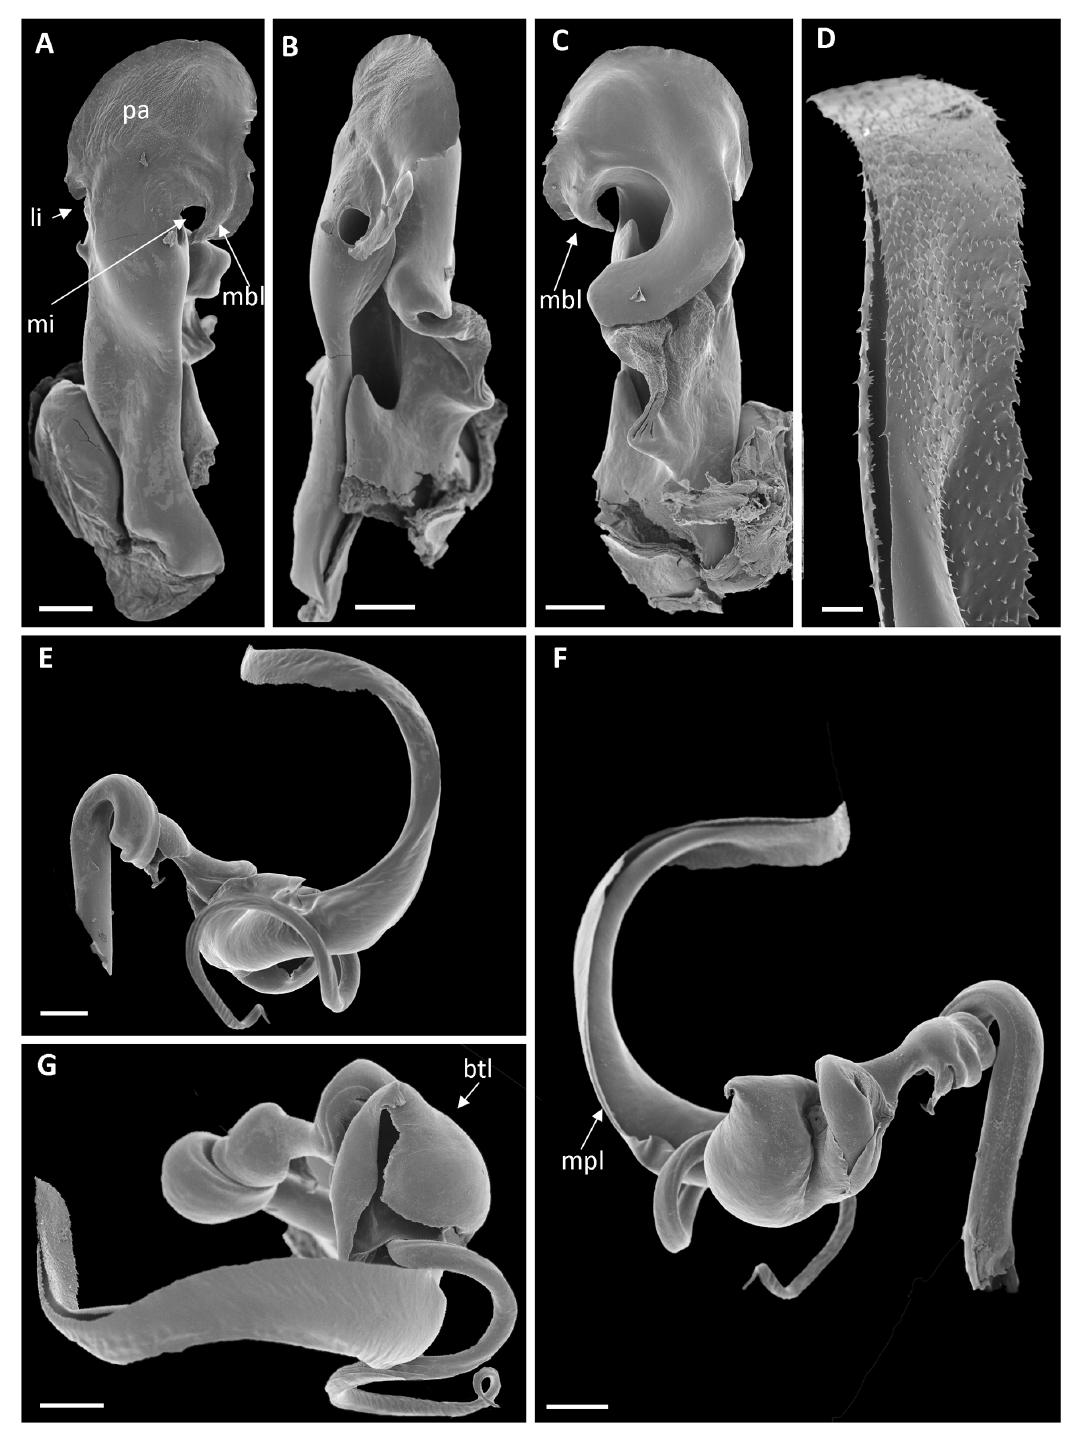
Fig. 10. Aquattuor claudiahempae Enghoff & Frederiksen, 2015, male, specimen from the Udzungwa Mts (NHMD 621639), left gonopod. A–C . Coxa. A . Anterior view. B . Mesal view. C . Posterior view. D – G . Telopodite. D . Tip of telomere. E . Anterior view. F . Posterior view. G . Mesal view. Abbreviations: btl = basal telomeral lamella; li = lateral incision; mbl = meso-basal lobe of palette; mi = mesal incision; mpl = mesal-posterior telomeral lamella; pa = palette. Scale bars: A–C, E–G = 0.1 mm; D = 0.02